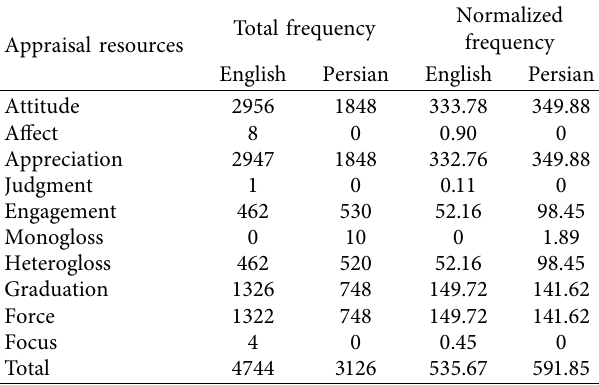
Table 1: Frequencies of appraisal resources in English and Persian academic research articles.